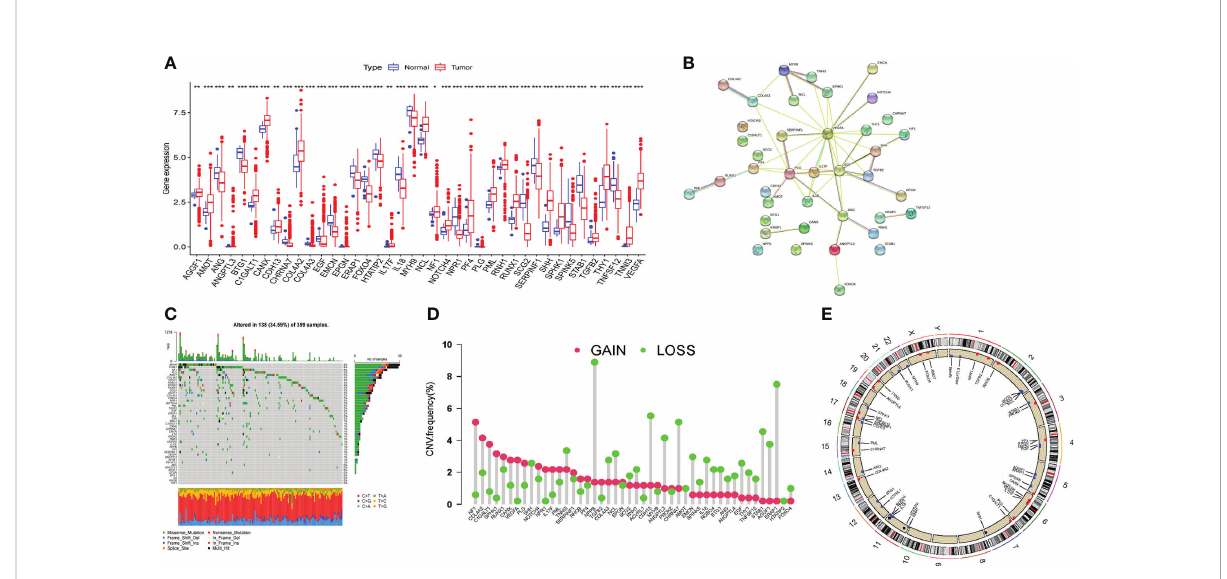
FIGURE 1 Expression and mutation of angiogenesis related genes in TCGA-COAD cohort. (A) Differential expression of angiogenesis related genes (ARGs) between tumor tissue and normal tissue. (B) The protein-protein interaction (PPI) network of the differentially expressed genes. (C) The incidence of somatic mutations of ARGs in COAD patients. (D) The CNV frequency of ARGs in TCGA cohort. (E) The locus of CNV alterations of 48 ARGs on 23 chromosomes. Adjusted p-values were shown as * P <0.05, ** P <0.01, *** P